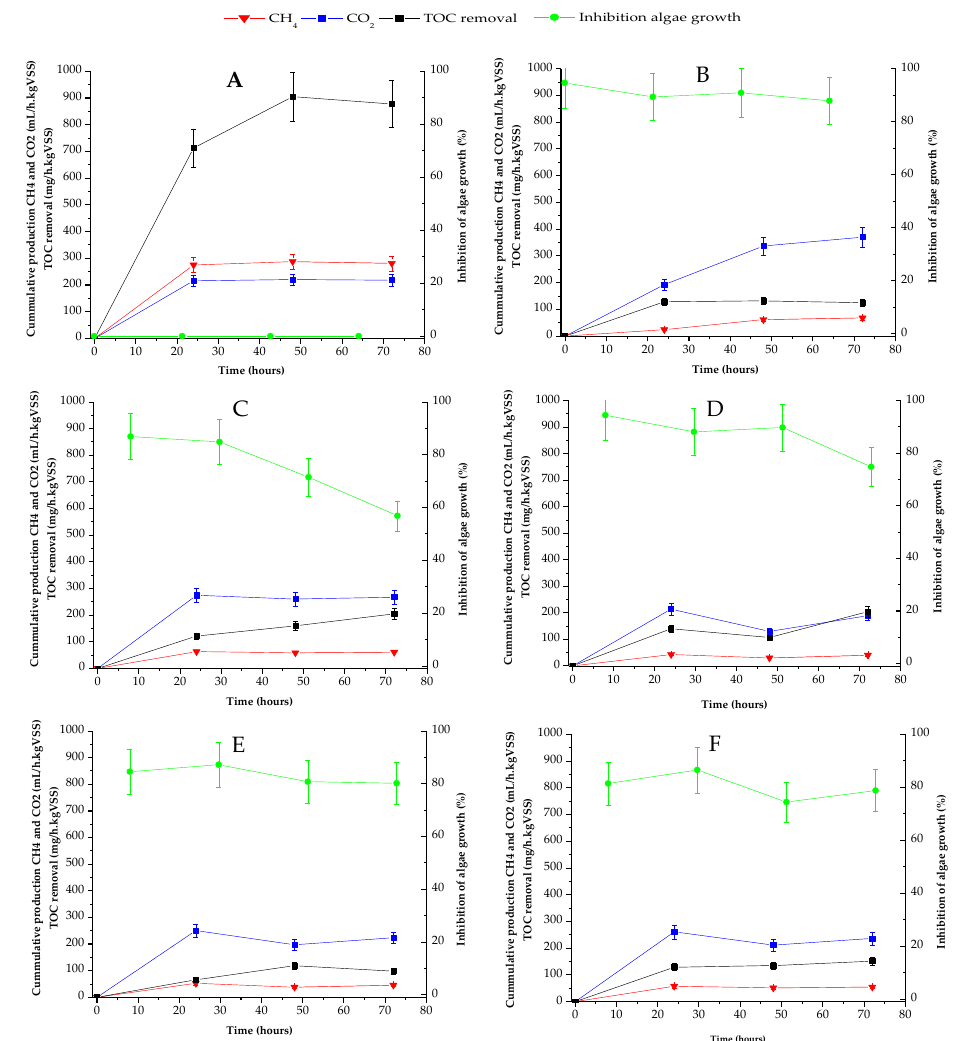
Figure 1. Organic matter removal (in black squared lines), biogas production (in red triangular and blue rhomboidal lines) and ecotoxicity (in green circled lines) in anaerobic reactors: ( A ) Control reactor without pollutants; ( B ) Reactor containing SFM; ( C ) Reactor containing CBM; ( D ) Reactor containing IBU; ( E ) Reactor containing TCS; ( F ) Reactor containing mixed pollutants.